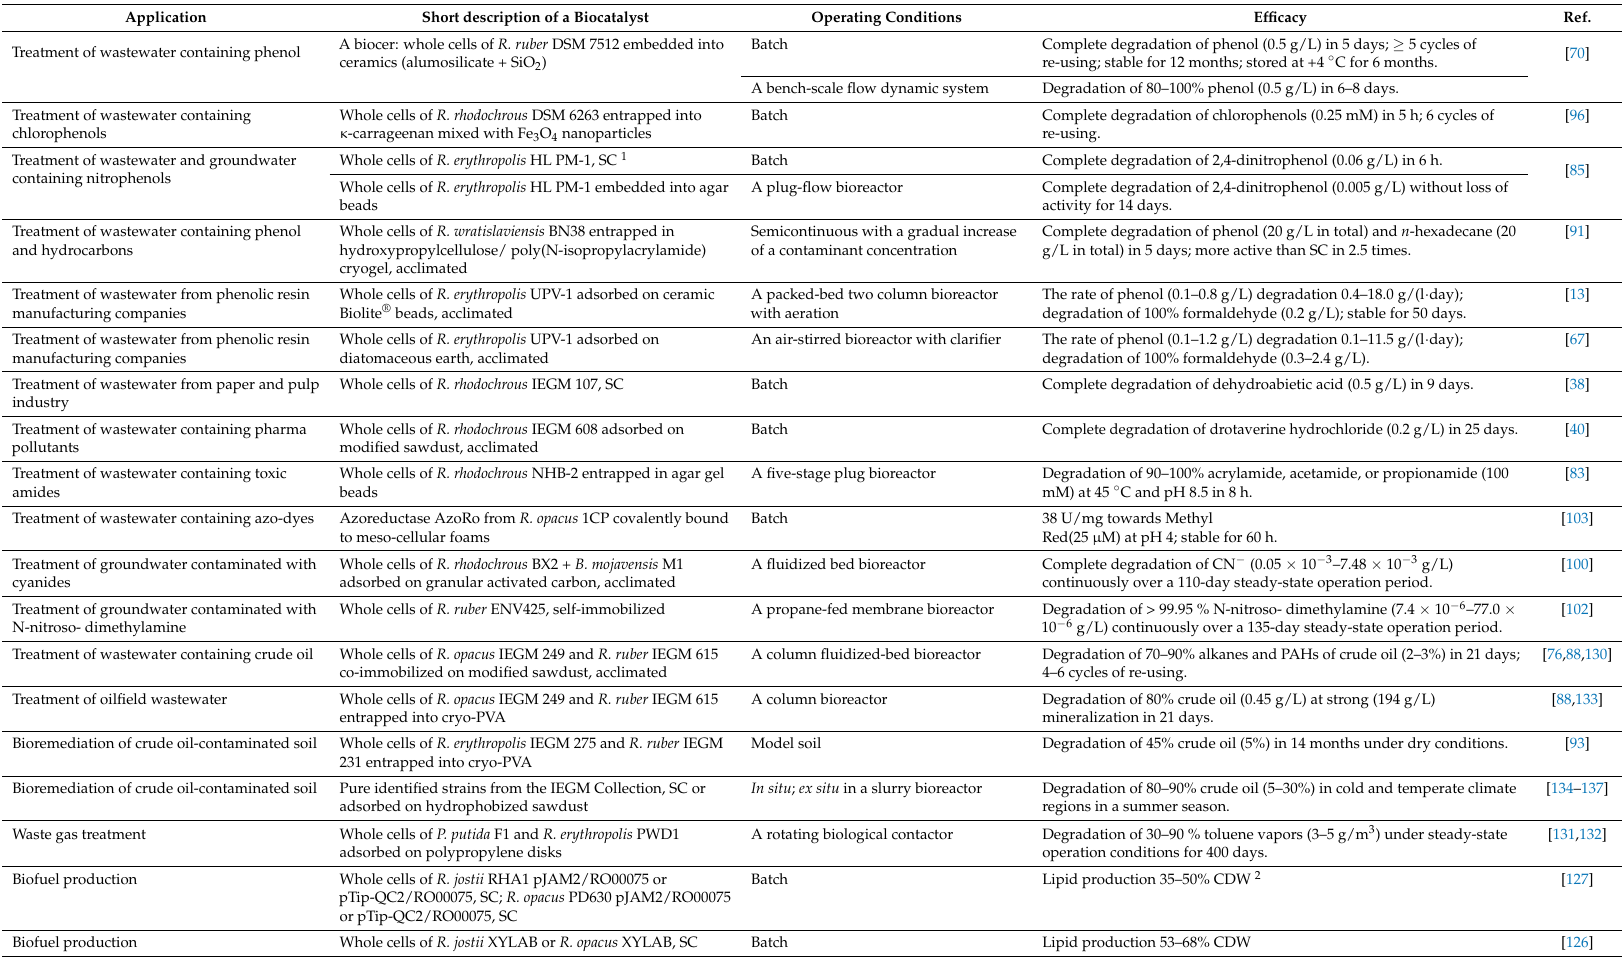
Table 1. Selected examples of Rhodococcus biocatalysts developed for environmental